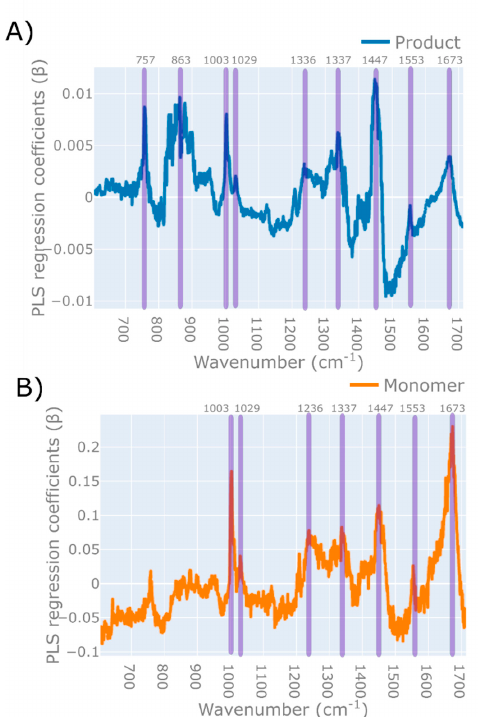
Figure 8. PLS regression coefficient ( 𝛽 ) plots for each PLS model generated for ( A ) the monomer purity model and ( B ) product concentration, with the wavenumbers corresponding to the Raman molecular signature of each variable highlighted by the shaded areas. The cut-off points for these PLS regression coefficients are product: β > 0.005; monomer β > 0.075. The PLS model for monomer purity was developed using the raw spectra. The PLS model for the product concentration was developed using spectra that was baseline-corrected using a 1st order polynomial function, followed by the application of an SNV scattering scatter algorithm and a Savitzky–Golay smoothing filter. The PLS model for product concentration utilised 7 latent variables and the model for monomer purity utilised 8 latent variables.